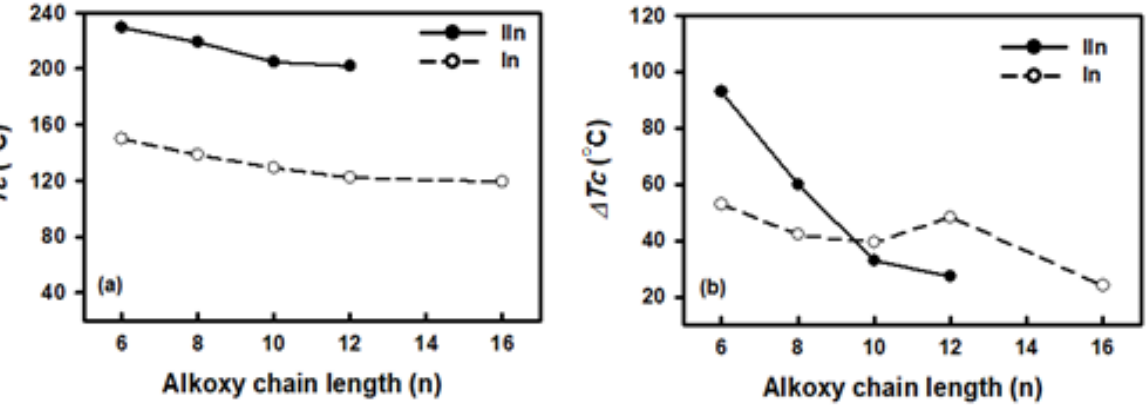
Figure 6. Comparison of ( a ) T c and ( b ) ∆ T c of homologues series I n and II n .